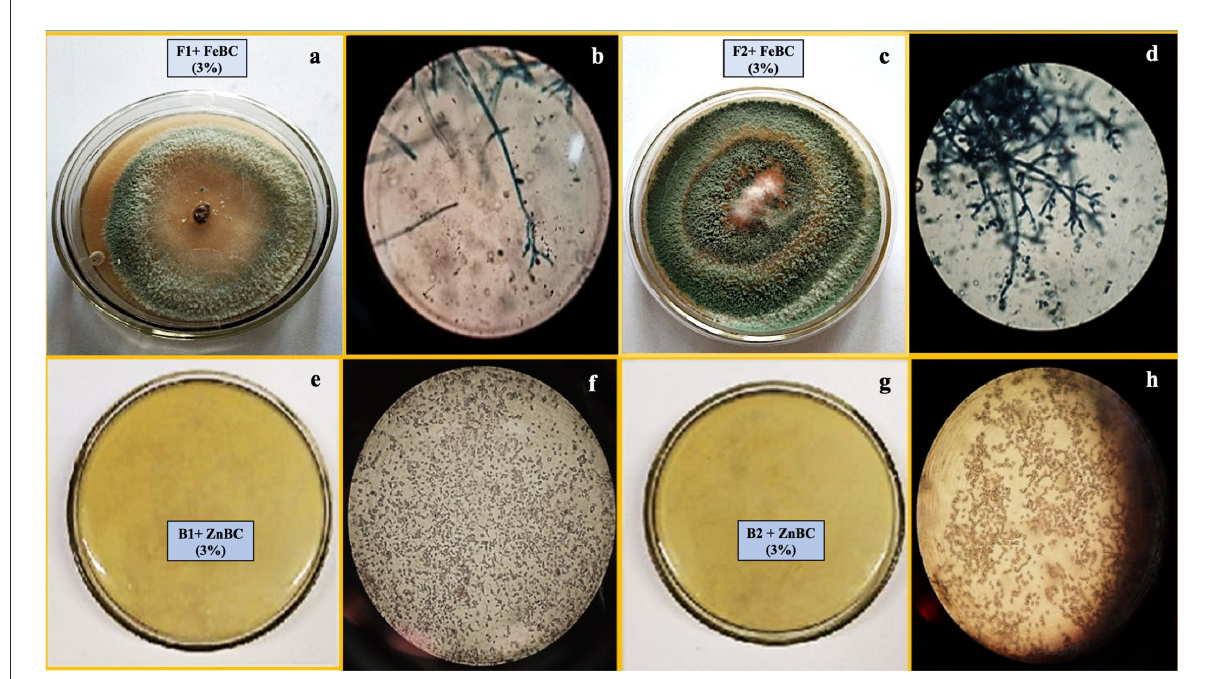
FIGURE3 Images of T. harzianum fungal sp. from harvested soil (a) growth pattern (b) microscopic study and T. viride soil inoculated plate (c) growth pattern (d) microscopic study; images of P. fluorescence bacterial sp. from harvested soil (e) growth pattern (f) microscopic study and B. subtilis sp. from harvested soil (g) growth pattern (h) microscopic